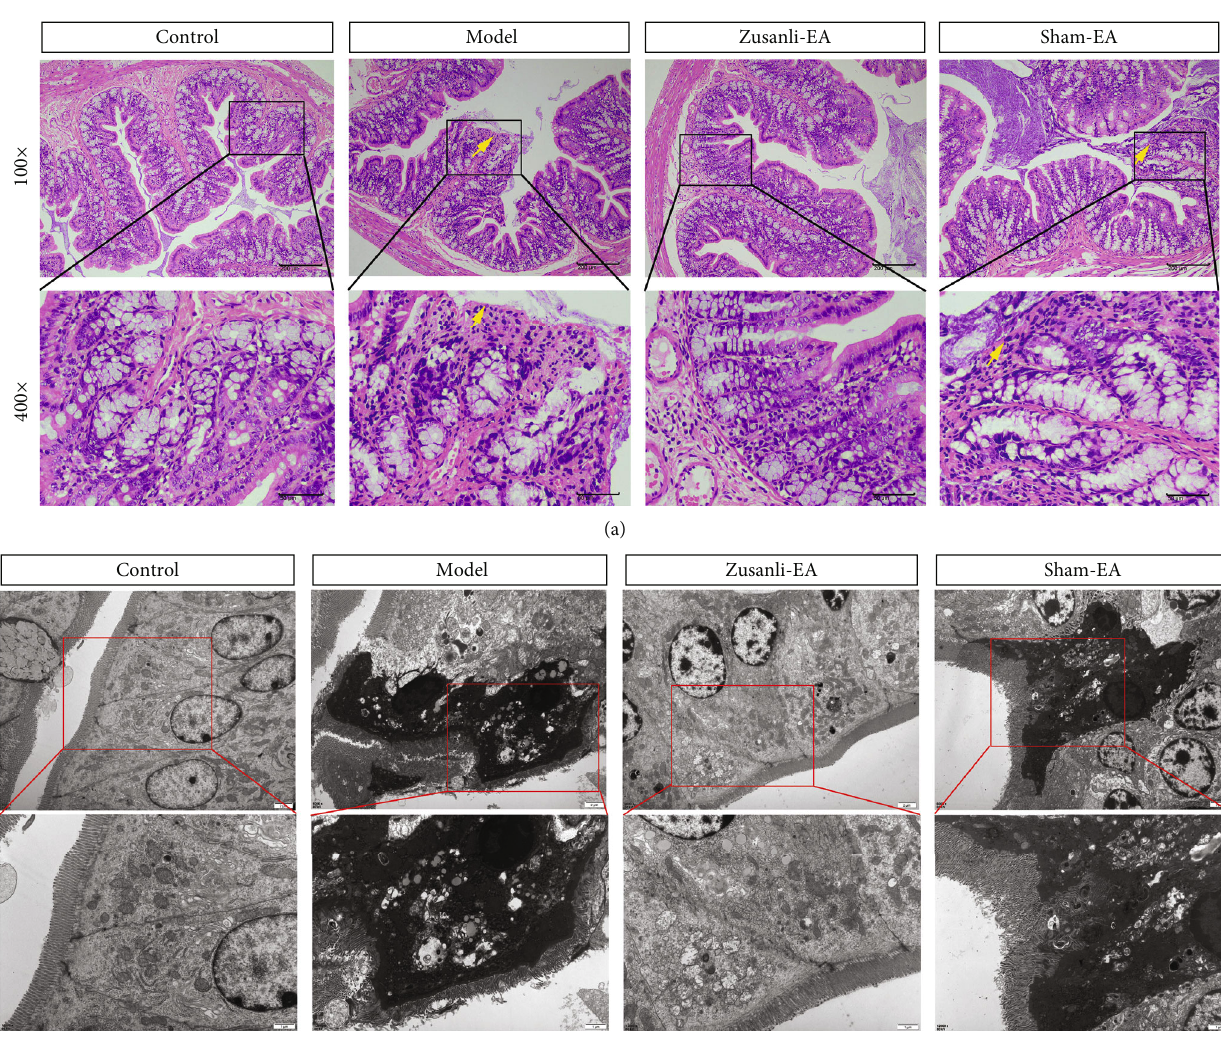
Figure 2: EA improved pathological lesions of L6 DRG in DSS-induced colitis rats. (a) Representative picture of colonic H&E stain. The magni fi cations are 100x and 400x. The destruction of mucosal layers is indicated by the arrows. (b) Transmission electron microscopy (TEM) micrograph of L6 DRG in DSS-induced colitis rats. The scale bar of the upper panel is 2 μ m. The scale bar of the lower panel is 1 μ